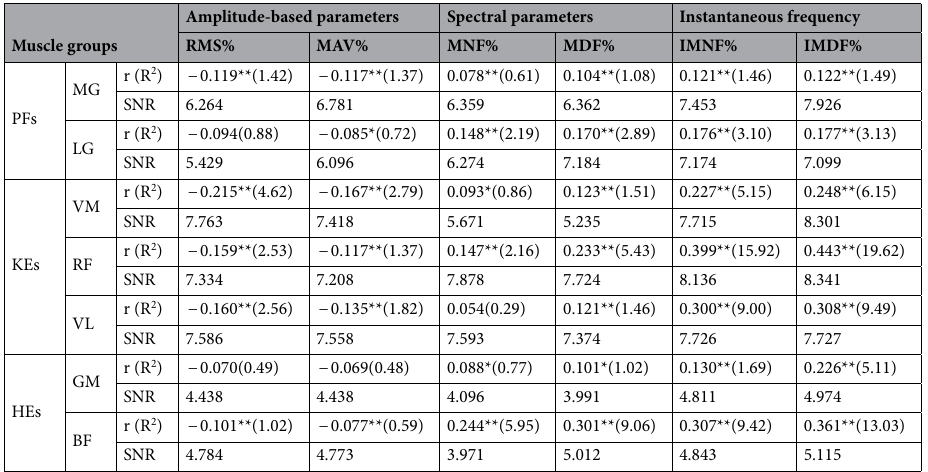
Table 1. Percent changes of linear time–frequency parameters against percent changes of peak power output and signal-to-noise ratio. PFs plantar flexors, KEs knee extensors, HEs hip extensors. MG medial gastrocnemius, LG lateral gastrocnemius, VM vastus medialis, RF rectus femoris, VL vastus lateralis, GM gluteus maximus, BF biceps femoris. r pearson’s correlation coefficients, R 2 coefficient of determination, SNR signal−to−noise ratio. RMS root mean square, MAV mean absolute value, MNF mean frequency, MDF median frequency, IMNF instantaneous mean frequency, IMDF instantaneous median frequency. * P < 0.05, ** P < 0.01, the correlations were